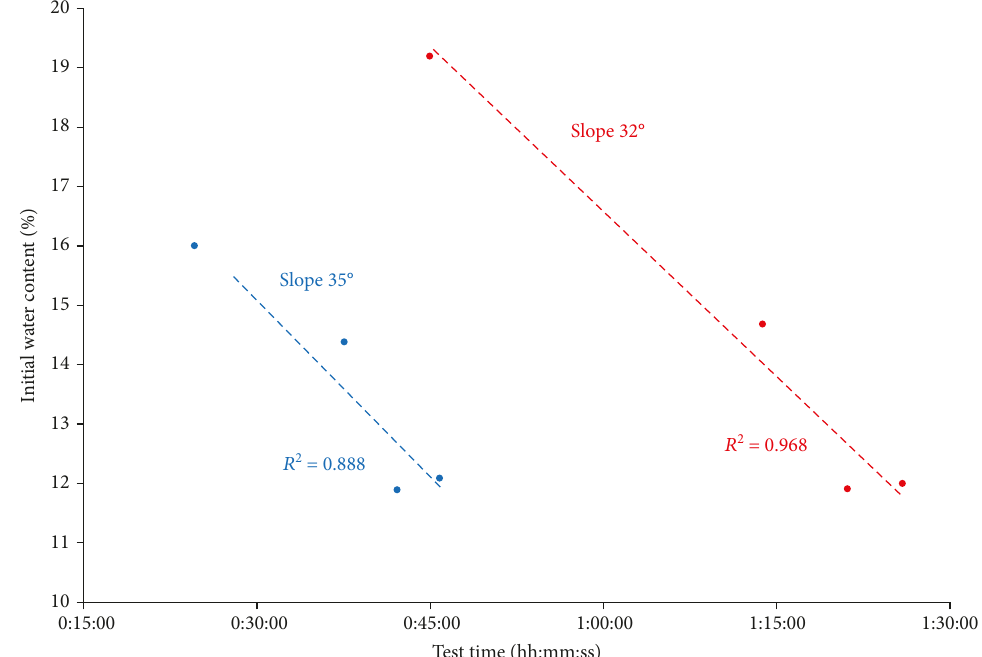
Figure 6: Failure time vs. initial water content for di ff erent fl ume